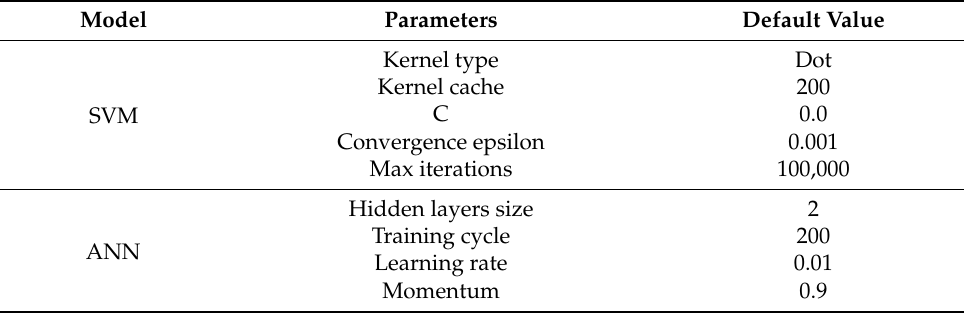
Table 2. Default settings of model parameters in RapidMiner